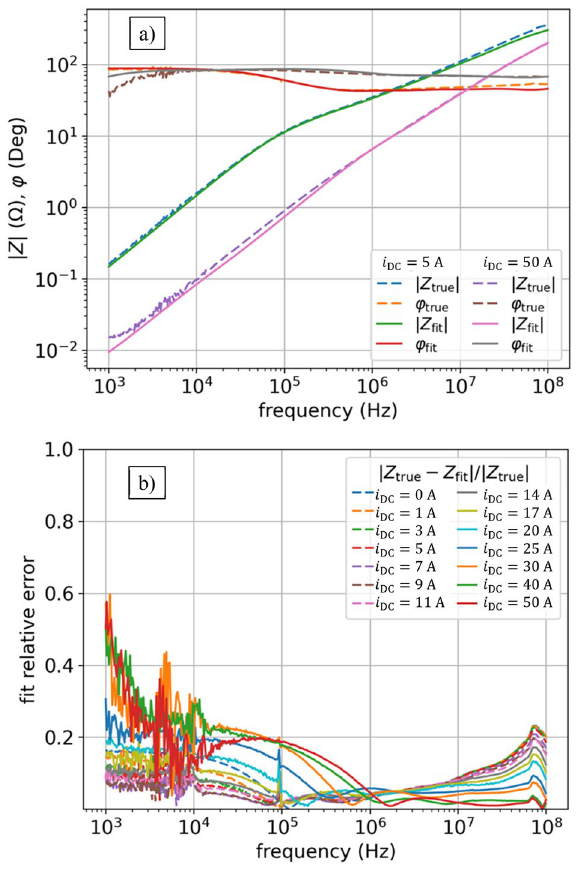
Figure 3. NLS results of impedance Z ( f , i DC ) fitting for model (3): ( a ) fit vs true values of | Z | (cid:31) f , i DC (cid:30) and ϕ( f , i DC ) for two currents: i DC = 5 A, i DC = 50 A; ( b ) relative error as per (4) for all